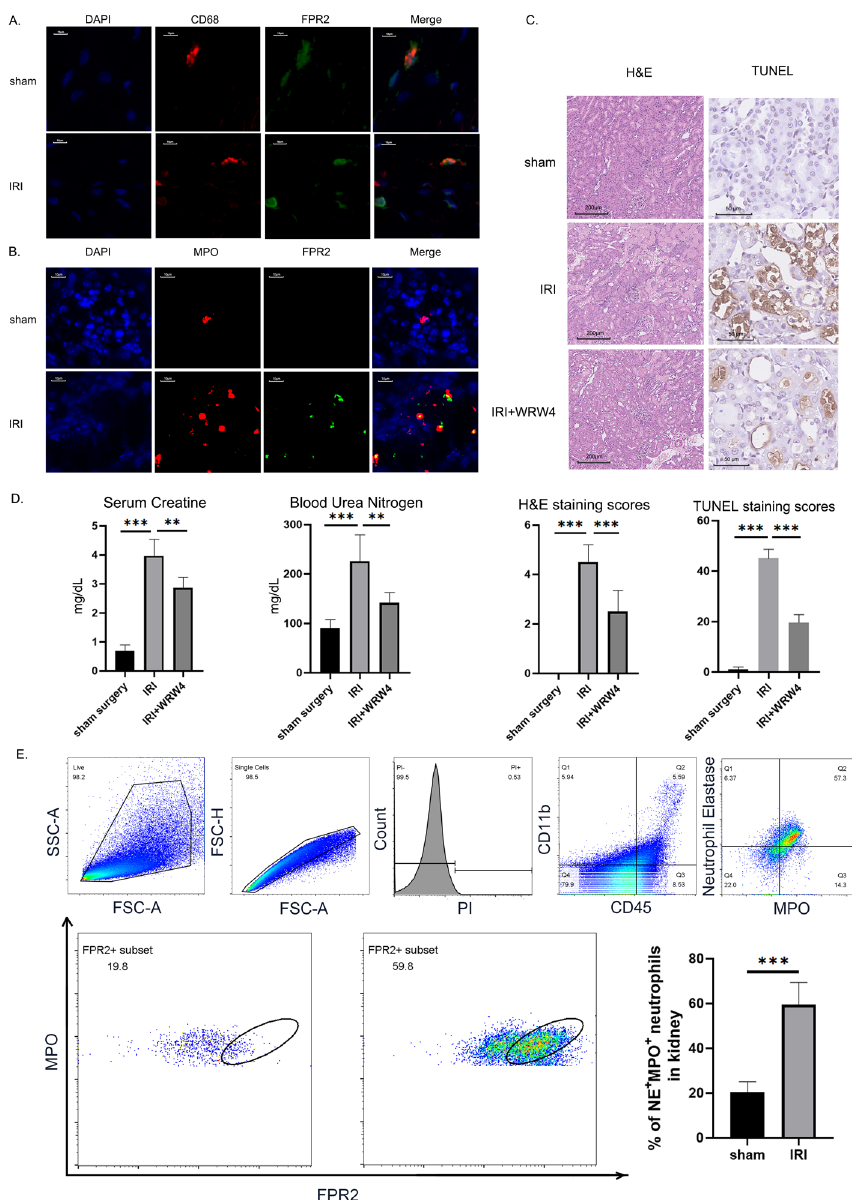
Fig. 1 Inhibition of elevated FPR2 is protective against kidney injury. The left renal pedicle of the rat was clamped for 45 min to induce IRI. The right kidney was removed before releasing the clamps. WRW 4 was administered intravenously 30 min before surgery. Serum or kidney tissues were collected 24 h after surgery. A , B Immunofluorescence staining of FPR2 colocalization with CD68 + macrophages and MPO + neutrophils. Scale bar, 10 μm. Representative images from one experiment out of three are shown. C Kidney tissues were sectioned for histological examination and TUNEL staining. Scale bar, 100 μm. Representative images from one experiment out of three are shown. D Serum from sham surgery, IRI, and WRW 4 -treated rats was sampled at 24 h after surgery. Serum creatinine and blood urea nitrogen levels were measured. E The percentages of FPR2 + neutrophils in kidney tissues were determined by flow cytometry. The results are presented as the mean SEM from three independent experiments. ** P < 0.01, *** P < ±